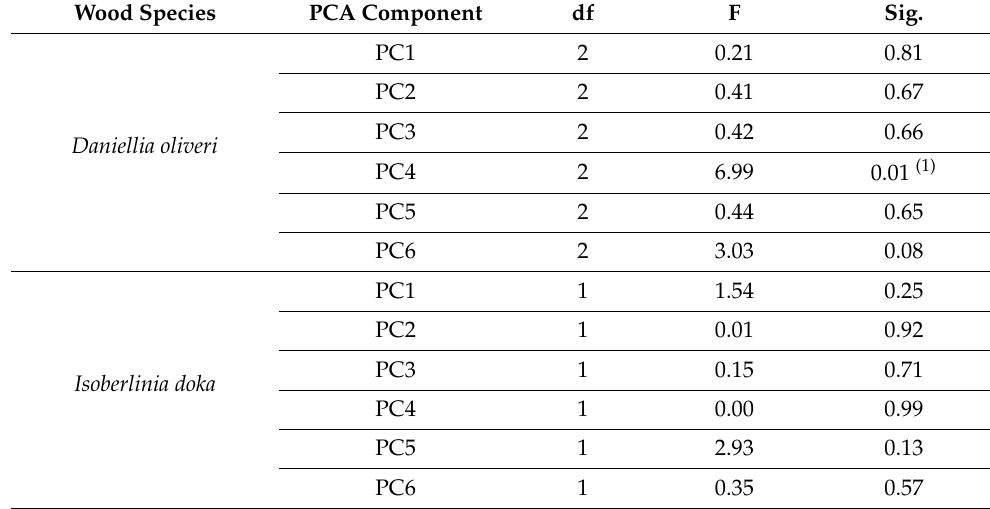
Table 4. Summary of the one-way ANOVA using component scores of PCA components.